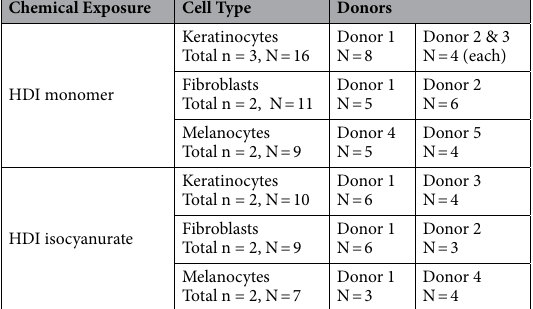
Table 1. Number of donors (n) and viability experiments ( N ) performed per donor for HDI monomer and HDI isocyanurate